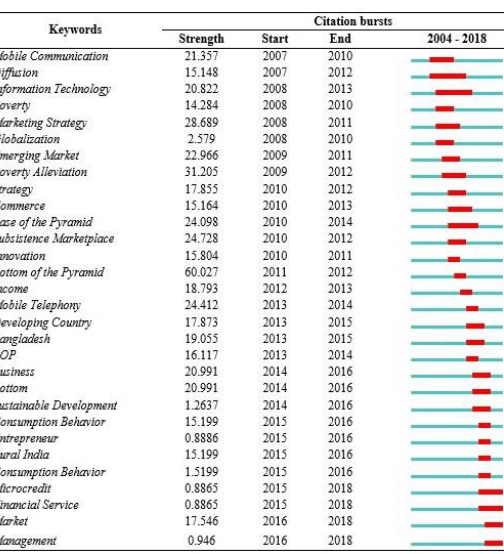
Figure 6. Network of Co-Citations of Works Cited by Articles in the Search (Frequency >=